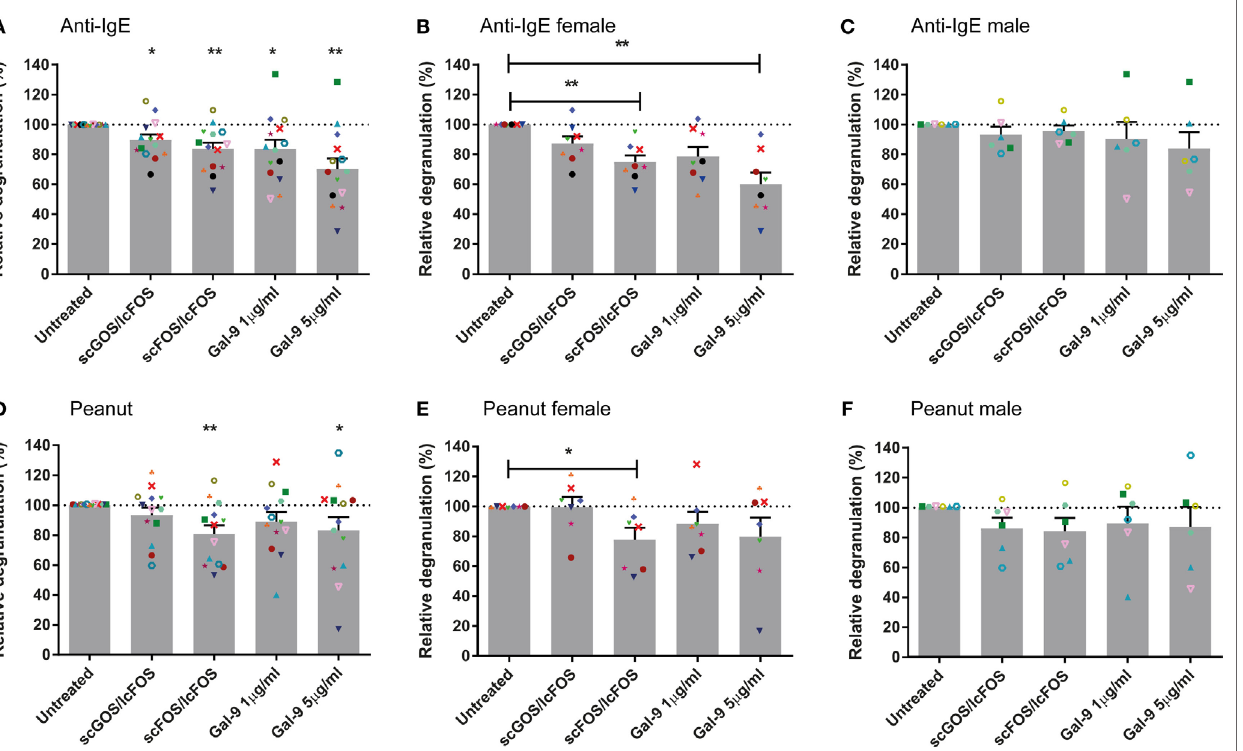
FigUre 2 | Reduced basophil degranulation after pre-incubation with non-digestible oligosaccharides (NDOs) or galectin-9. Pre-incubation of whole blood for 24 h with NDOs of galectin-9 resulted in a decrease in IgE-mediated basophil degranulation (a–c) . Pre-incubation with short- and long-chain fructo-oligosaccharides (scFOS/lcFOS) and 5 µg/mL galectin-9 reduced peanut-specific basophil degranulation (D–F) . Females tended to have a higher decrease in basophil degranulation than males after pre-incubation (B,c,e,F) . Data represent the mean ± SEM of n = 15 peanut-allergic patients, two patients were unresponsive ( < 5% basophil degranulation) in the peanut-specific basophil activation test (BAT), one of these two patients was also non-responsive in the IgE-mediated BAT. * P < 0.05, ** P < 0.01 by one-way